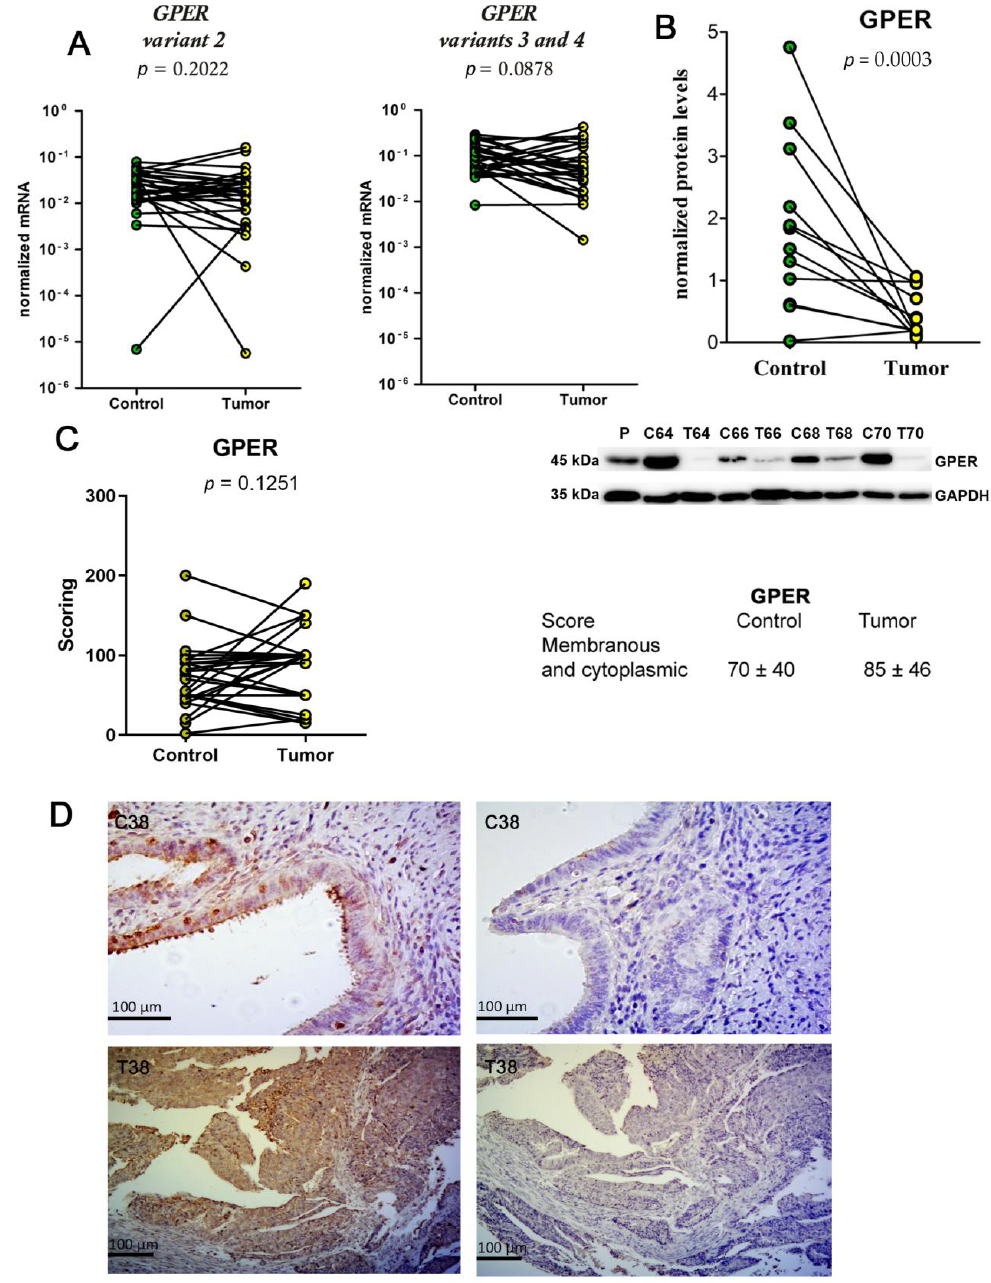
Figure 5. Expression of GPER in endometrial cancer tissue and adjacent control endometrium at the mRNA and protein levels. ( A ) Before-and-after graphs show the normalized expression levels of the GPER gene variants 2, and variants 3 and 4 (as indicated) in control endometrial tissue (Control) and the corresponding EC tissue (Tumor). The levels of gene expression are on a logarithmic scale. ( B ) ECL detection of GPER. 18 paired samples were analyzed using anti-GPER antibodies (HPA027052, Sigma-Aldrich, Cat. #: HPA027052, Lot: A61748) in the control endometrial tissue ( C ) and EC tissue (T). Placenta (P) was used as the positive control. Below, the detection of GAPDH used for quantification. Before-and-after graph shows the GPER protein levels in the control and EC tissue. ( D ) IHC staining in representative paired adjacent control endometrial tissue (C38) and EC tissue (T38) for GPER. In the negative controls (Control), the primary antibodies were replaced with serum of the same animal species (rabbit). Anti-GPER antibodies were validated by Western blotting analysis (Supplementary Figure S7, Supplementary Table